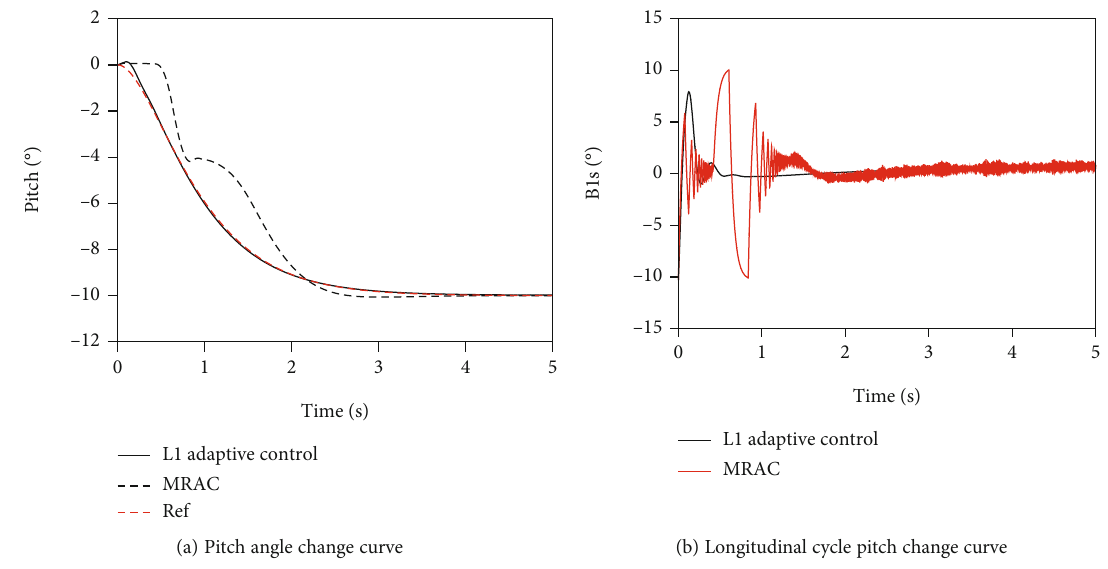
Figure 6: The pitch angle and longitudinal cycle for helicopter